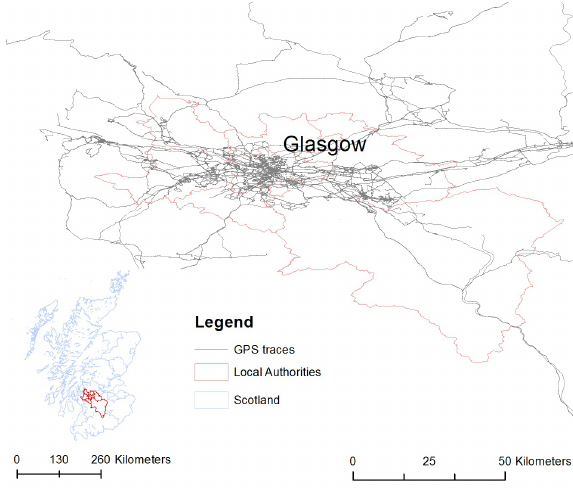
Figure 2: Study area of the iMCD project covered Glasgow City and six surrounding local authorities. The map presents the cov- erage of the study with GPS footprints of 358 users from whom we had obtained the valid